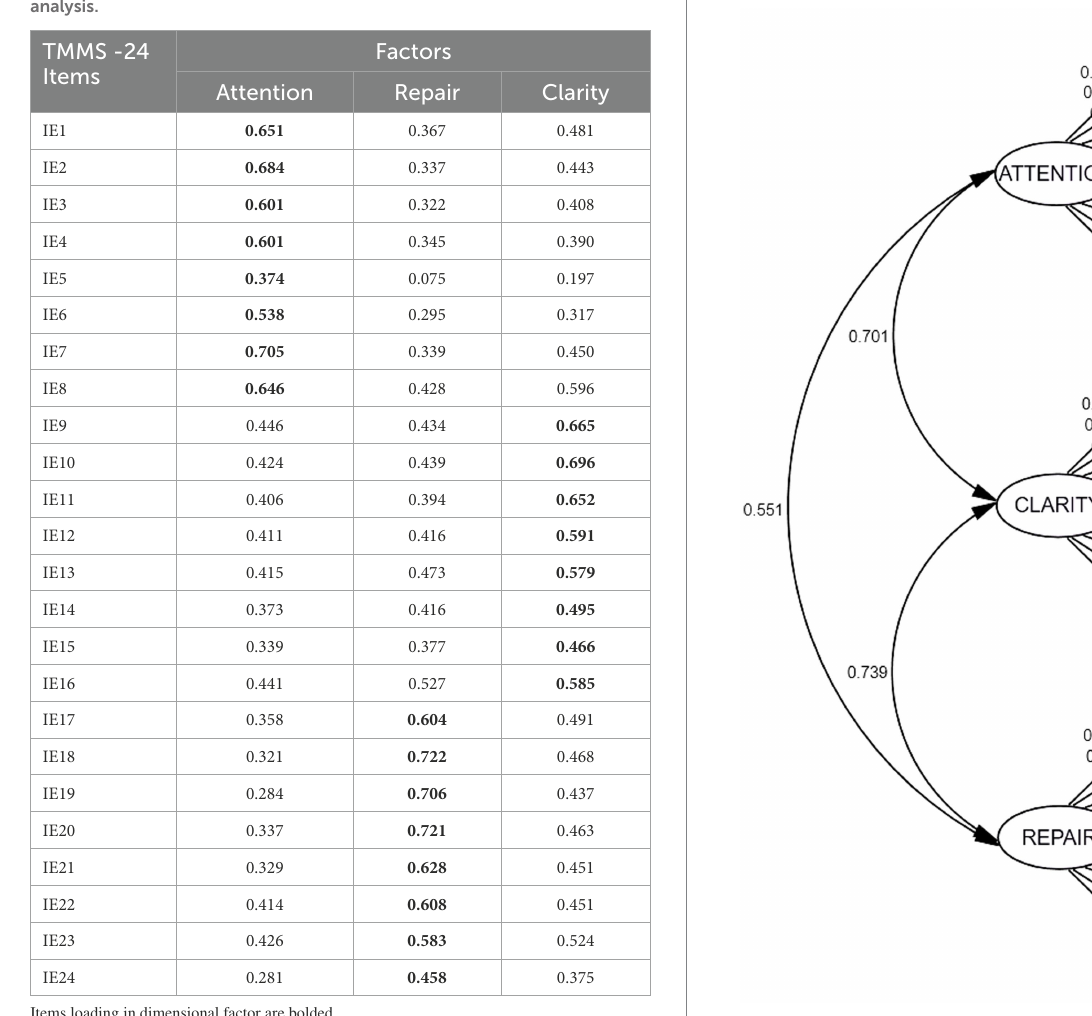
FIGURE 1 CFA of the final 1st order three-factor TMMS-24